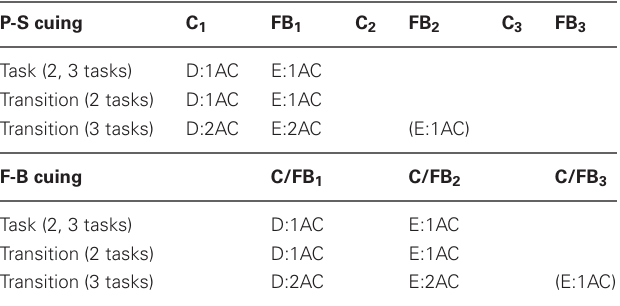
inform about the correctness of the response, R x , on the P-S cuing condition. Specifically, C 1 -cues (shown in blue) require set shifts, and FB 1 -feedback stimuli (shown in orange) enable evaluating the task-set decision. C/FB x -hybrid stimuli inform about the correctness of the response, R x , on the F-B cuing condition. In the absence of other information, this feedback simultaneously serves as contextual information about possible state transitions. Specifically, a set shift is required when C/FB 1 -stimuli (shown in blue) signal that R 1 was erroneous, whereas C/FB 2 -stimuli (shown in orange) enable evaluating the task-set decision.